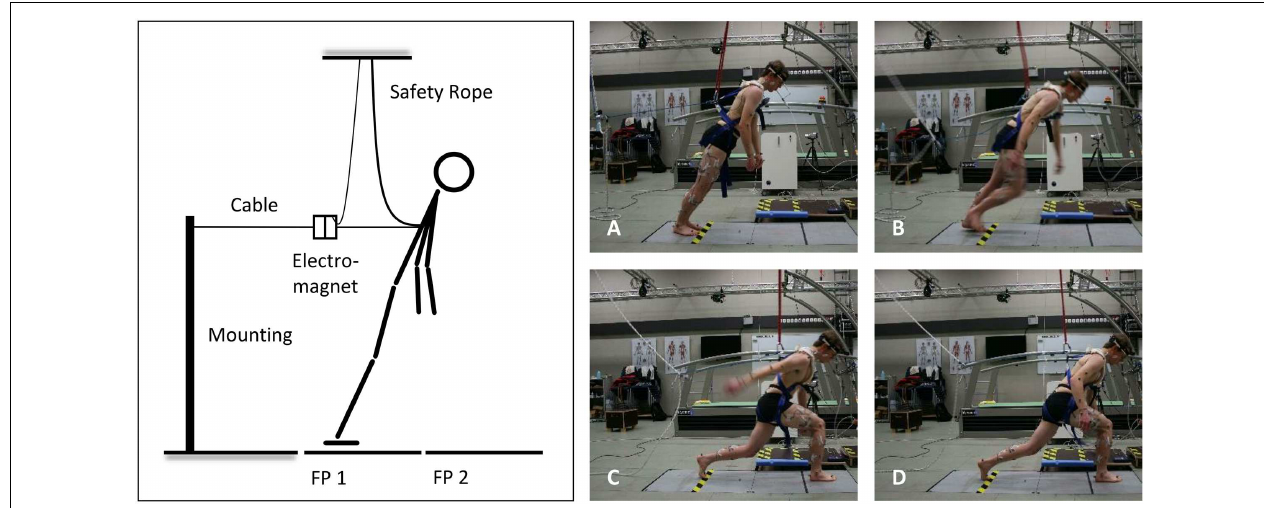
FIGURE 1 | Schematic illustration of the experimental setup (left) and the analyzed time points (right): release of the subject (A), toe-off from the ground of the recovery limb (B), touchdown of the recovery limb (C), and 500 ms after touchdown (D); FP, force plate.